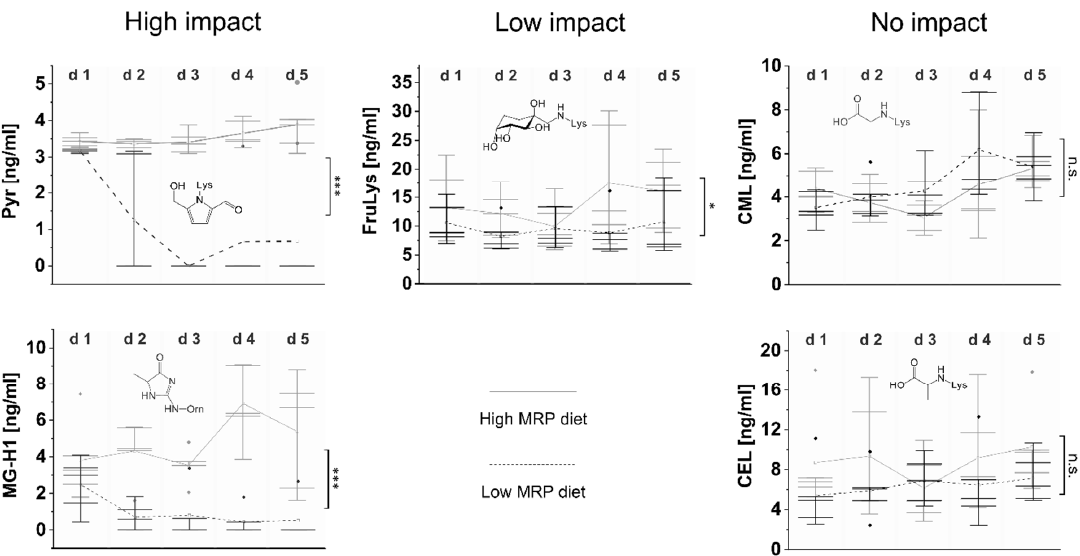
Figure 1. Impact of dietary MRP intake on salivary MRP concentrations, analyzed during a crosso ‐ ver ‐ study with low and high MRP intake (grey: high MRP intake, black: low MRP intake). Shown are boxplots of salivary concentrations of individual MRPs in the morning of five consecutive days of five subjects with sampling at 7 am. Outliers are indicated by a rhombus. Connected lines indicate data points of mean salivary MRP concentrations (low MRP diet: dashed line versus high MRP diet: solid line). The statistical analysis shown in the graph is related to the low versus high MRP diet curves. Significance: *** p < 0.001, * p < 0.05, n.s.—not significant. Table 2. Statistical significance (paired t ‐ test) during high versus low MRP diet with the significance levels *** p < 0.001, ** p < 0.01, * p < 0.05, n.s.—not significant. The term “d1 low” represents the starting conditions after the usual diet.